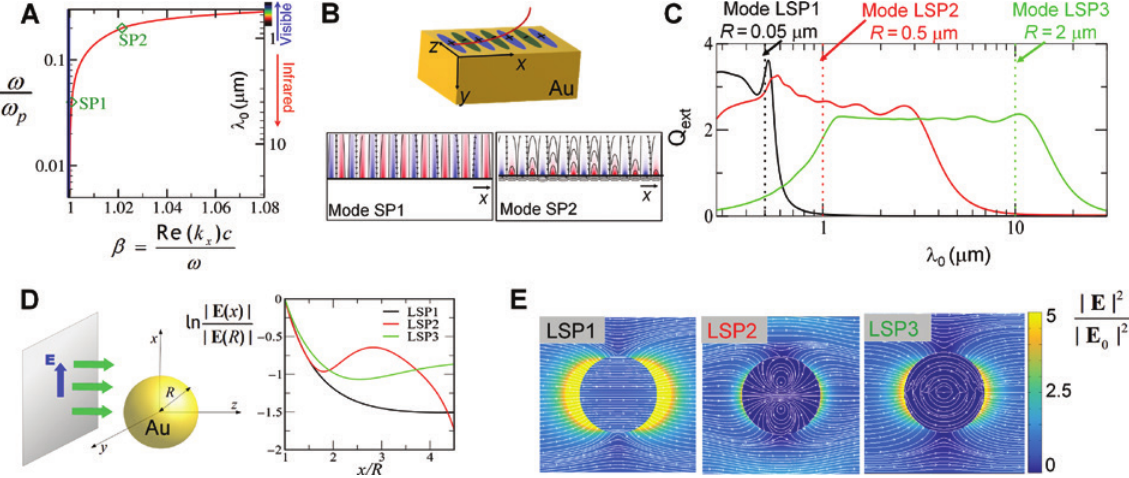
Figure 2: Planar and localized SPs from the IR to the visible spectrum. (A) SPP dispersion from IR to visible at the air-gold interface (red line). The frequency, ω , and wave vector k , are expressed in dimensionless x = ω / c , respectively; the vertical blue line is the units, by scaling them with the plasma frequency ω and the free-space wave vector k p 0 lightline. (B) x -component of the electric field with associated streamlines for selected modes designated in (A). (C) Extinction efficiency, Q , versus free-space wavelength λ for three different Au spheres with a radius R = 0.05 μ m (black line), R = 0.5 μ m (red line), and R = 2 μ m ext 0 (green line). (D) Field decay outside each of the gold spheres for selected modes designated in (B). | E ( x )| represents the magnitude of the electric field at distance x from the sphere’s center; R is the sphere’s radius. (E) Electric field intensity landscape | E | 2 normalized with the incident electric field intensity | E | 2 for the same modes with associated streamlines ( xy -plane 0